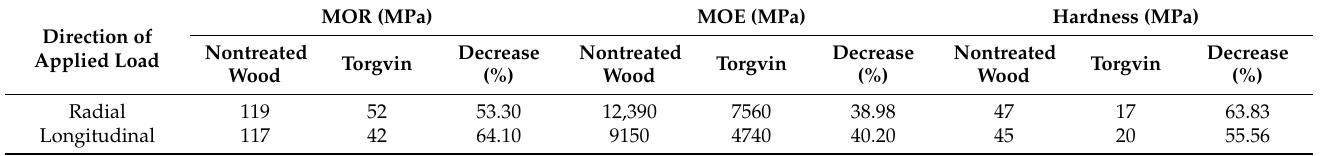
Table 9. Torgvin strength properties found by [52].